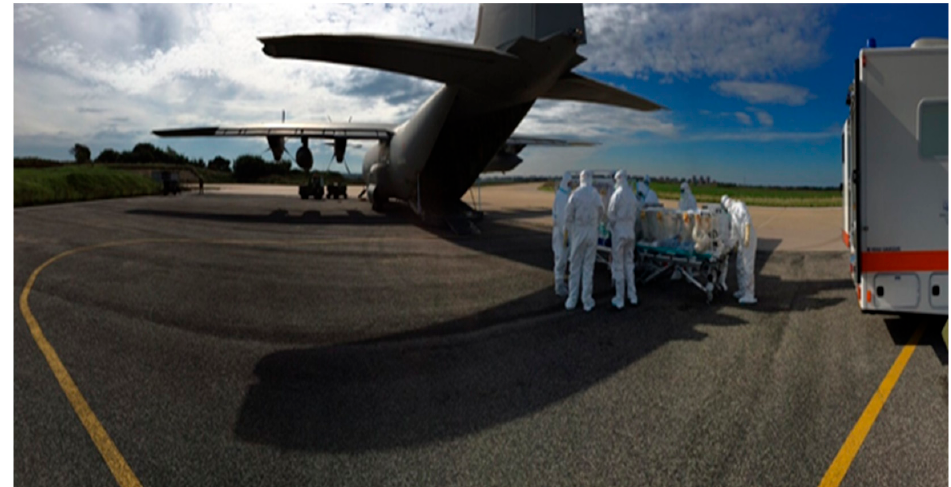
Figure 2. A high biocontainment aeromedical evacuation team engaged in the transfer of the Aircraft Transit Isolator (ATI) stretcher from the aircraft to the ambulance for subsequent transport of the patient to the hospital.